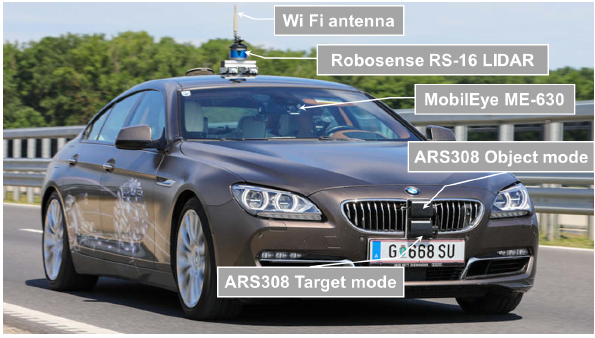
Figure 4. Test vehicle measurement